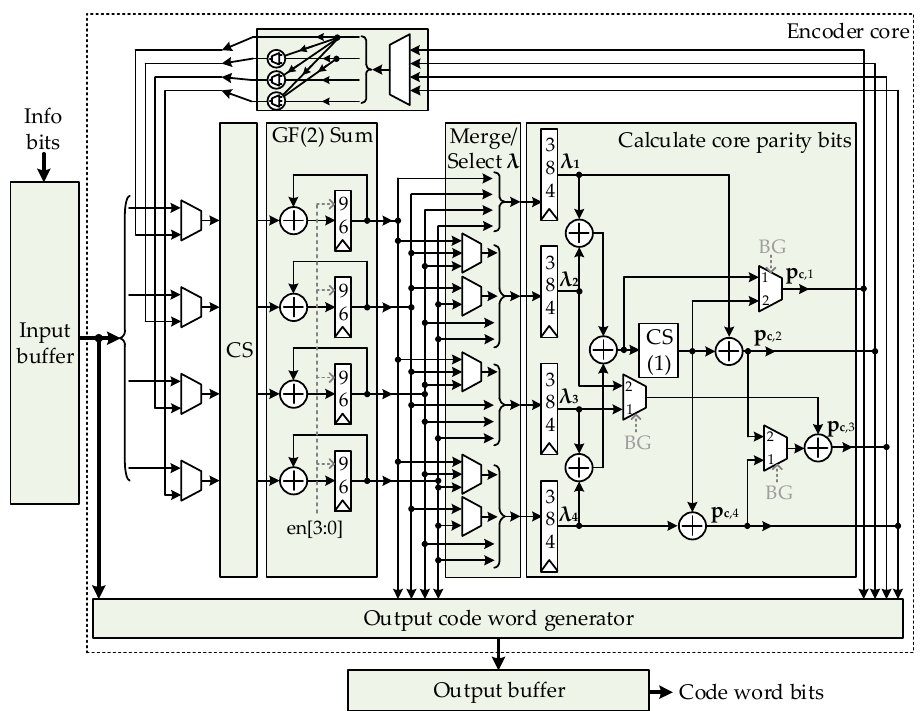
Figure 11. Proposed 5G NR LDPC encoder architecture.